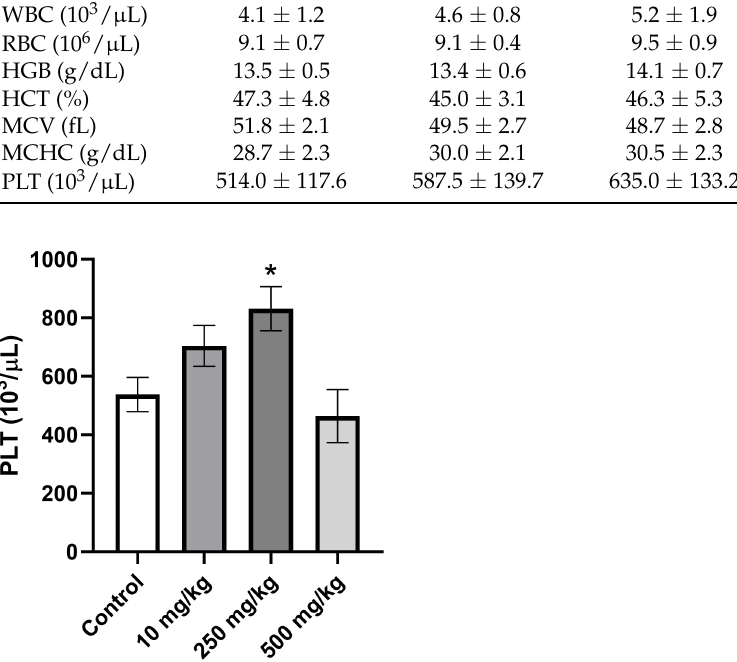
Table 6. Comparison of PsA versus vehicle control-treated hematological parameters white blood cell count (WBC), red blood cell count (RBC), hemoglobin count (HGB), hematocrit (HCT), mean corpuscular volume (MCV), mean corpuscular hemoglobin concentration (MCHC), and platelet count (PLT) in female Swiss albino mice. Data shown as mean ± SEM for n = 5/sex/group. Parameters